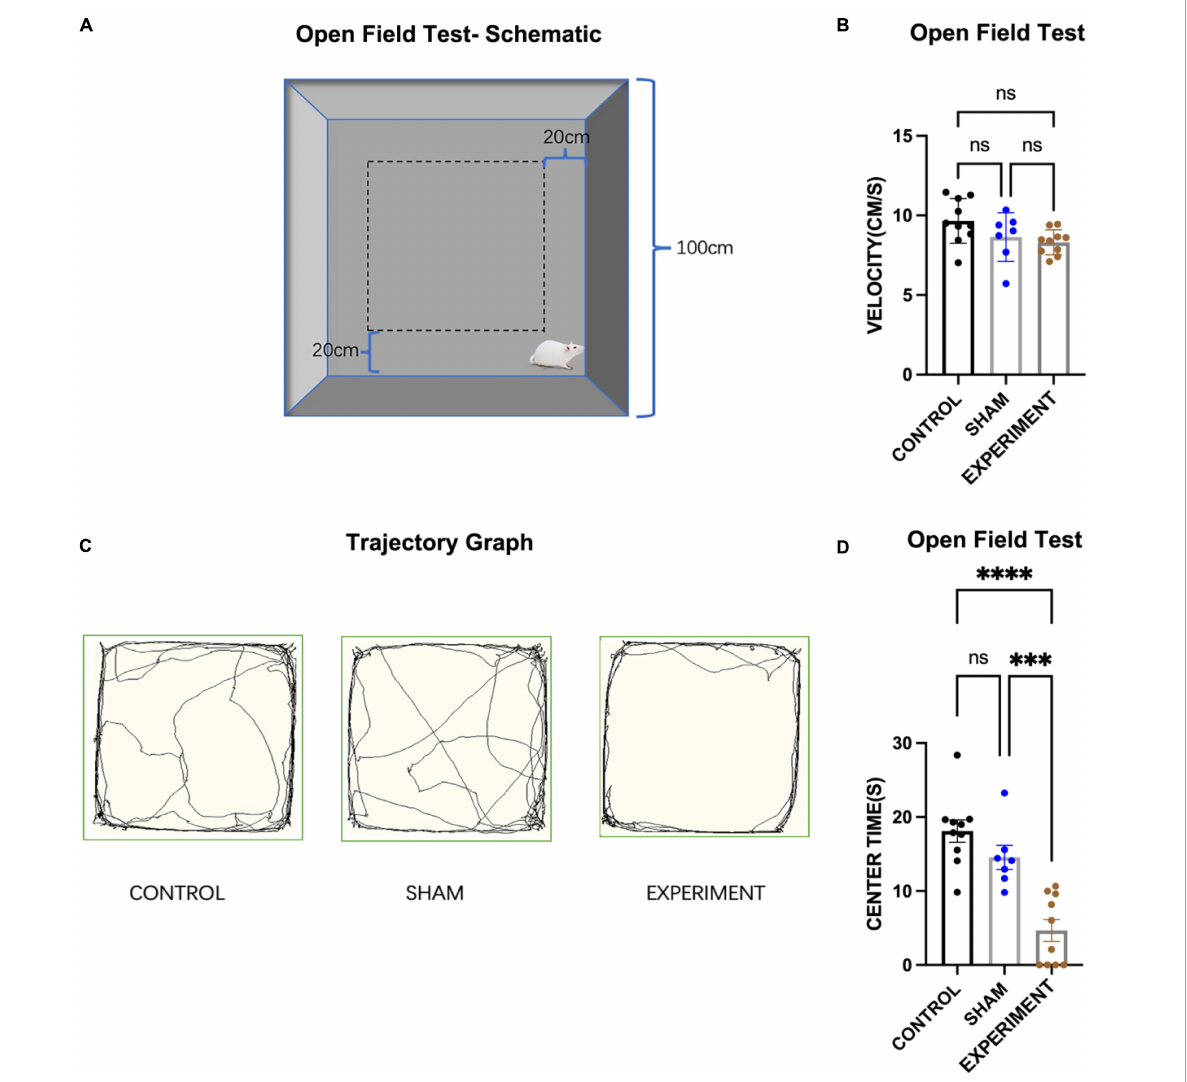
FIGURE3 Open-field test. (A) Schematic diagram of the open field test. (B) The movement speeds of the rats (mean ± SD). (C) Movement trajectory paths of the rats. (D) The times spent in the central area (mean ± SD). ∗∗∗ p < 0.001, ∗∗∗∗ p <